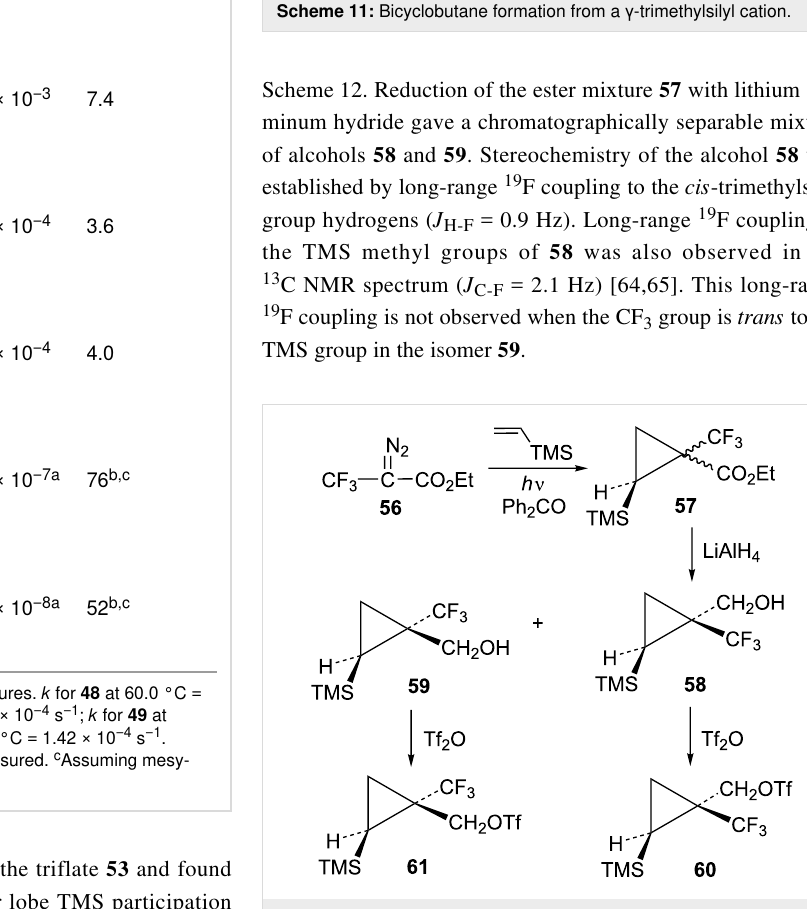
Scheme 11: Bicyclobutane formation from a γ -trimethylsilyl cation.